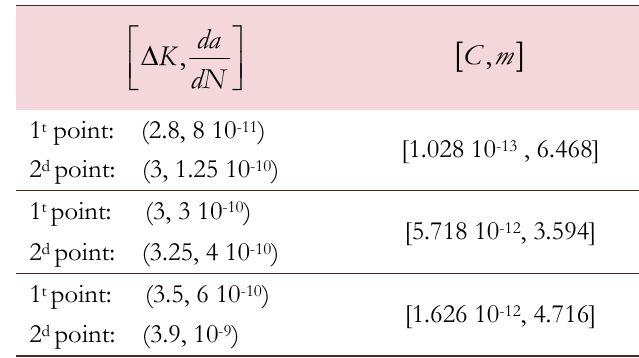
Table 2: The parameters C and m in Kinetics region I.